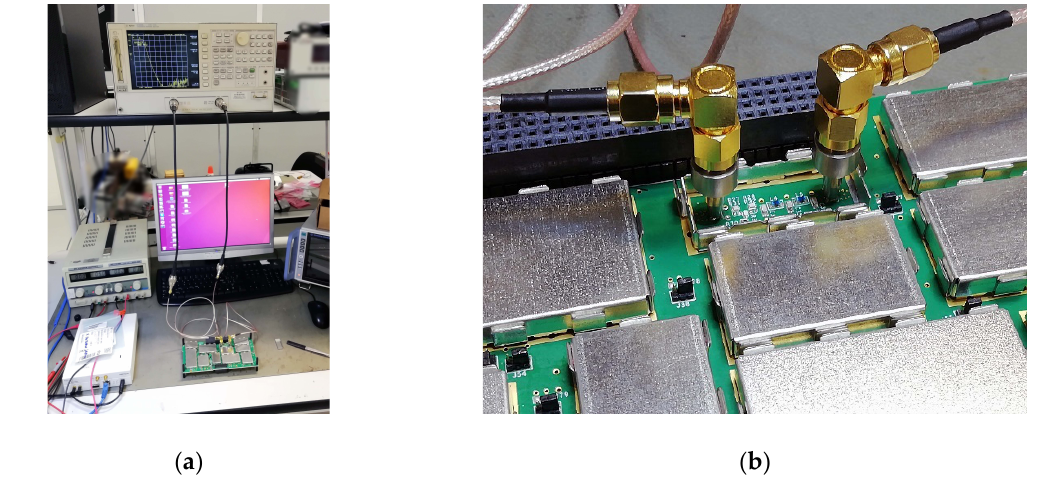
Figure 5. Photograph of the test setup implemented to test the custom IF section (390 MHz) low-pass filter: ( a ) The whole test setup; ( b ) A zoom on the mate of the instrument connectors to the filter RF test points.